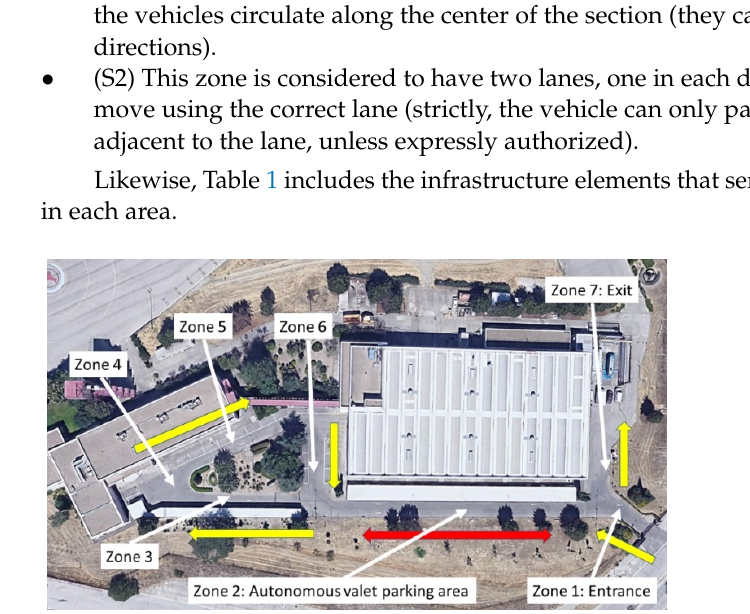
Figure 6. Parking area of University Institute for Automobile Research. Table 1. Reference elements for vehicle guidance.